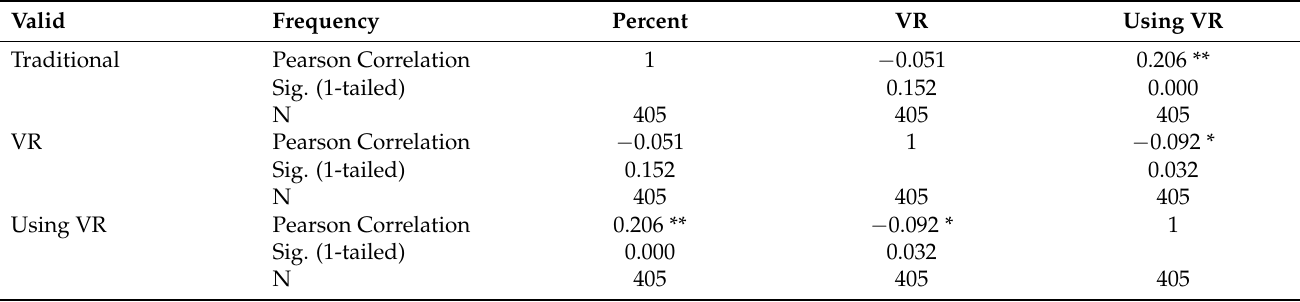
Table 8. Correlation—item total statistics.